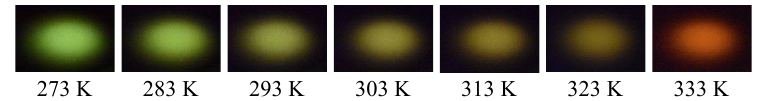
Figure 5. Photographs of the excited chameleon luminophore in the polymer at different temperatures taken by a single lens reflex camera (D3400, Nikon). The exposure time was 0.01 s. ISO sensitivity was 25,600. The aperture was f/6.3.